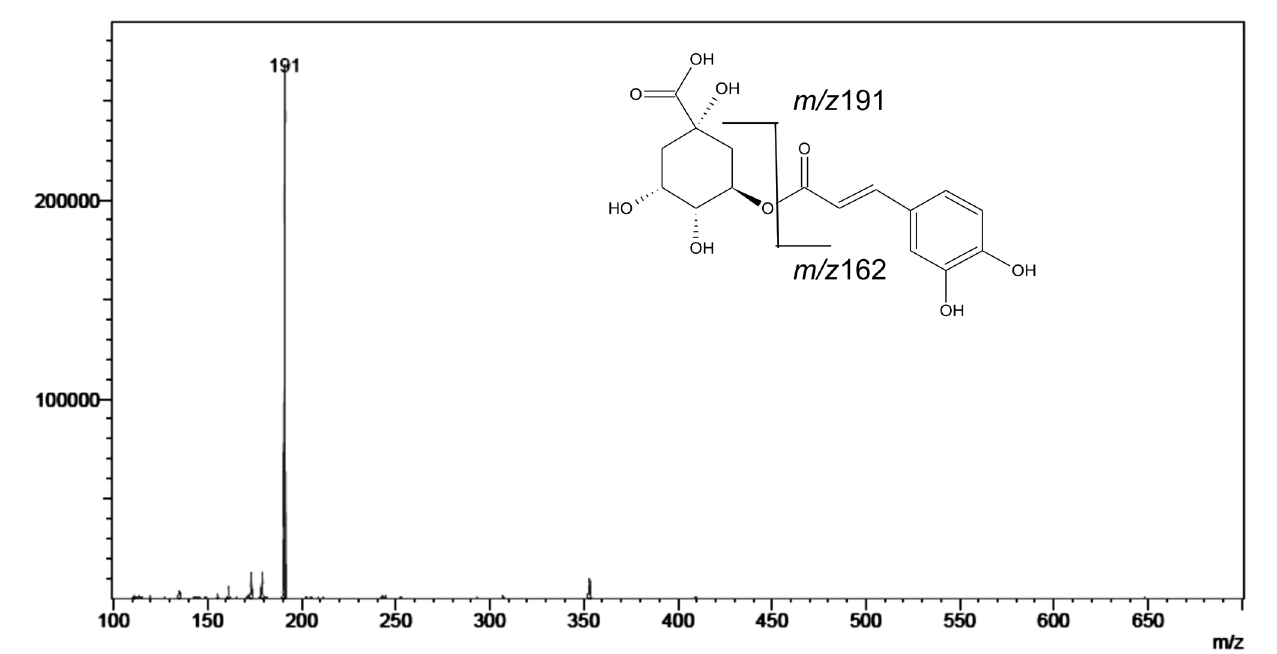
FIGURE 3 - The MS² spectrum of the precursor ion m/z 353 using 20eV of collision